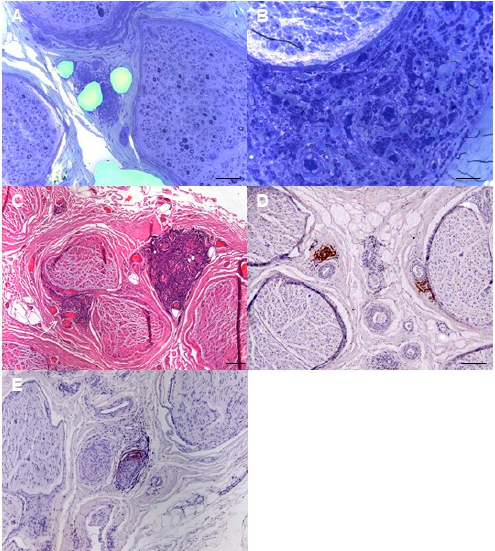
Figure 3. Sural nerve biopsy from patients with neurolymphomatosis. ( A ) Epineurial monomorphic perivascular infiltrate of lympho-monocytes and mild loss of myelin fibers in nerve fascicles are observed (semithin section, toluidine blue, original magnification 20 × ; bar 100 µ m). ( B ) Diffuse lymphomatous infiltration involves the epineurium and perineurium (semithin section, toluidine blue, original magnifi- cation 40 × ; bar 50 µ m). ( C ) The epineurium is infiltrated by a voluminous monomorphic lymphoid cell accumulation; minor infiltrates are also observed in perivascular sites (arrows) (paraffin section, H&E, original magnification 10 × ; bar 100 µ m). ( D , E ) Immunocytochemistry with anti-CD20 anti- bodies demonstrates a prevalence of B lymphocytes in epineurial infiltrates in two different cases of neurolymphomatosis (paraffin sections, original magnification 20 × ; bar 100 µ